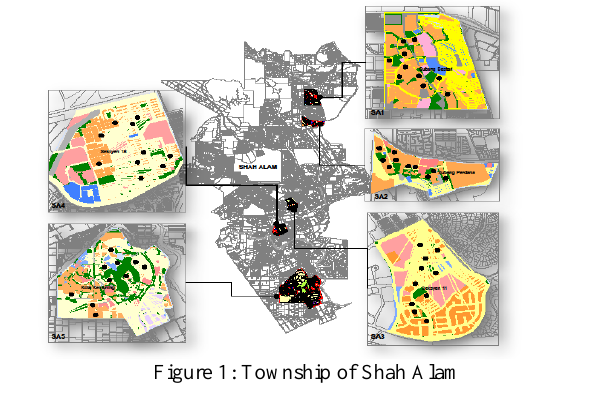
Figure 1: Township of Shah Alam